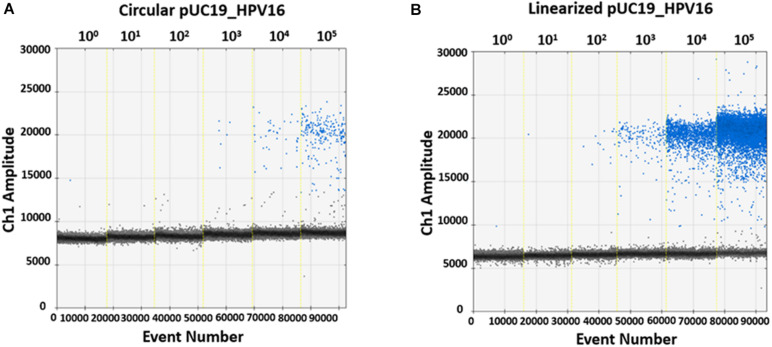
Representative quantification of pUC19_HPV16 plasmid with or without restriction enzyme digestion by ddPCR. (A) Copy number of pUC19_HPV16 plasmid without enzyme digestion. The circular pUC19_HPV16 plasmid was serially diluted from 105 to 100 copies/μL and ddPCR amplified. (B) Copy number of pUC19_HPV16 plasmid after restriction enzyme digestion. The enzyme-digested linearized pUC19_HPV16 plasmid was serially diluted from 105 to 100 copies/μL and ddPCR amplified. In A and B panels, vertical lines represent the fluorescent amplitude of the different plasmid concentrations: 100, 101, 102, 103, 104, 105 copies/μL.